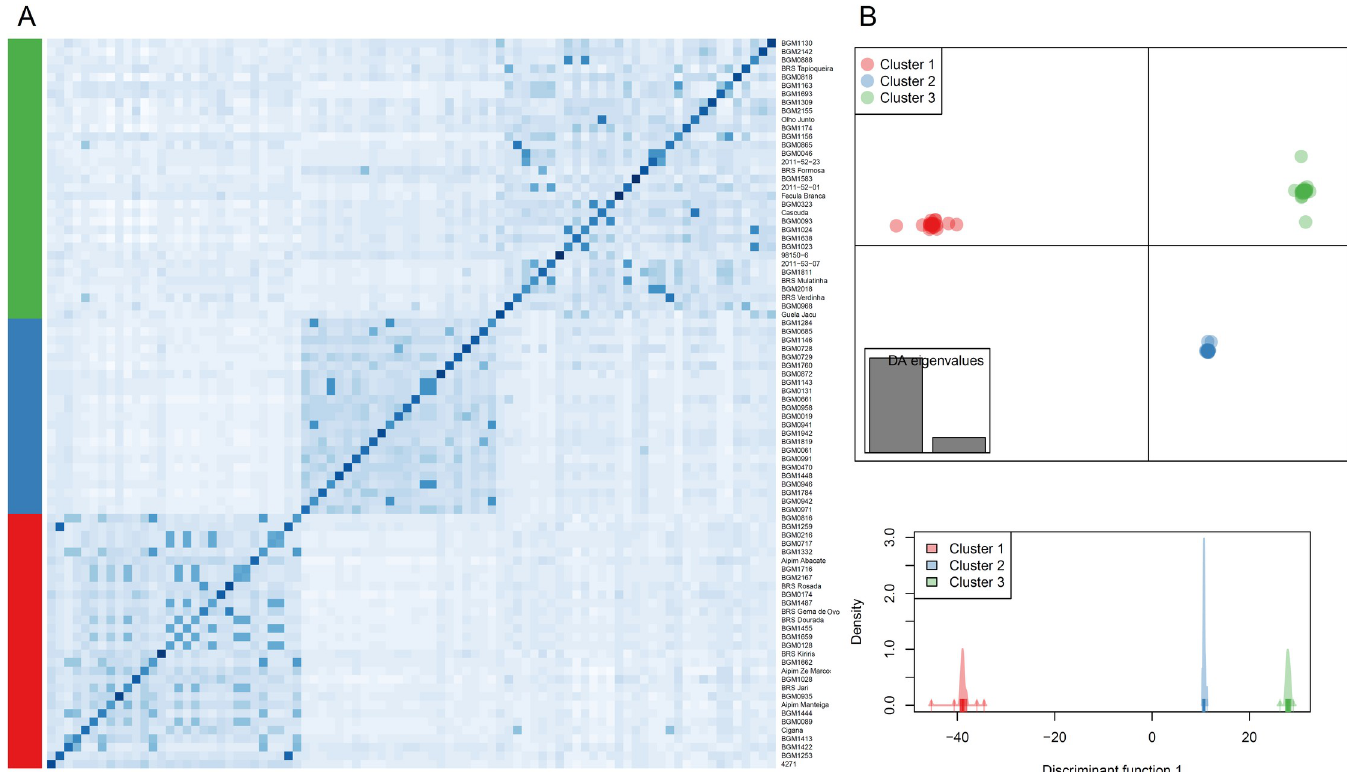
Fig 5. Population structure and genomic relationship obtained via the analysis of 16,300 single-nucleotide polymorphisms among 86 cassava parents. (A) Heat map of the genomic relationship matrix with the genotypes ordered according to the discriminant analysis of principal components (DAPC). The bar to the left of the heat map represents the DAPC group (i.e., Groups 1, 2 and 3 in red, blue and green, respectively). (B) The DAPC, in which the two axes of the upper graph represent the first two linear discriminants (LD). Each point represents an individual. The different subpopulations identified by the DAPC analysis are represented by the colors red, blue and green, while the bottom graph represents the distributions of the groups based on the first discriminant function only.